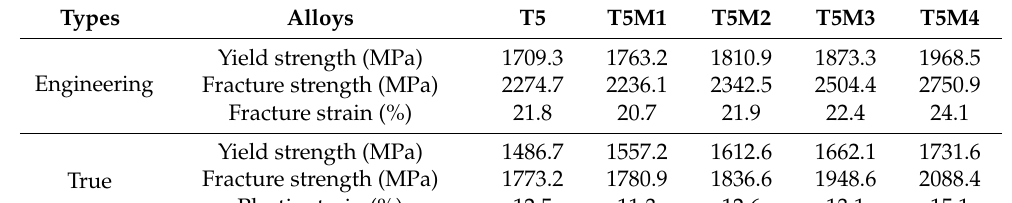
Table 3. Effect of Mo on the mechanical properties for the AlCrFeNiTi 0.5 HEA.